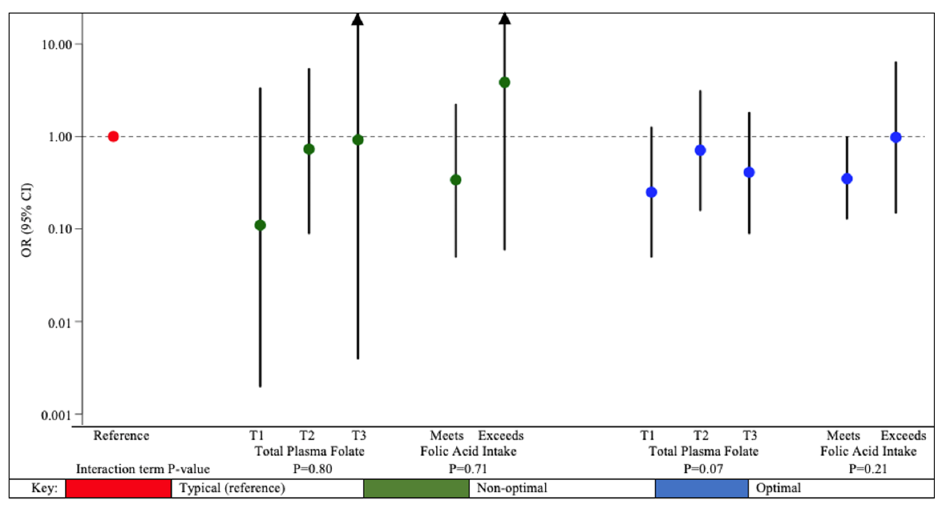
Figure 3. Adjusted odds ratios of neurodevelopmental phenotypic profile membership with 10-fold increase in maternal first trimester urinary DMA concentrations, stratified by terciles of total plasma folate and categories of folic acid intake from supplements among MIREC study participants.